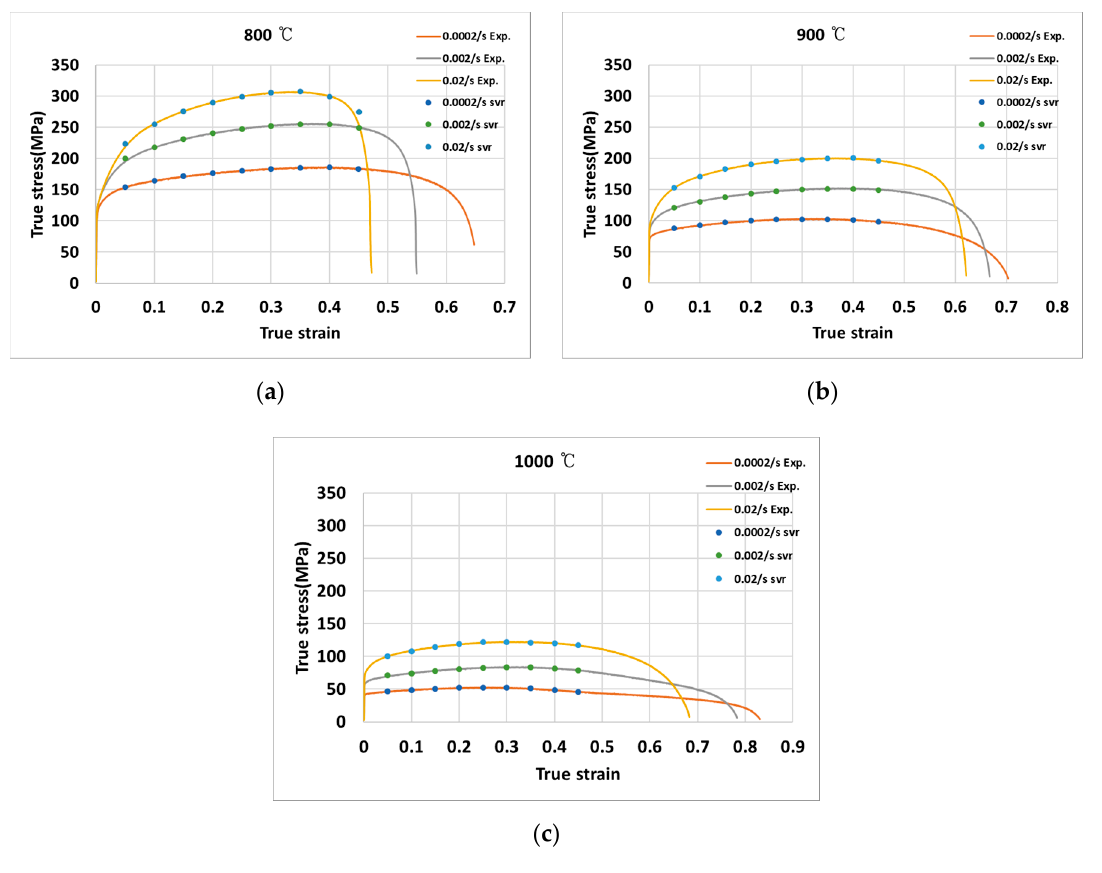
Figure 10. True stress-true strain curves at ( a ) 800 °C; ( b ) 900 °C; ( c ) 1000 °C.